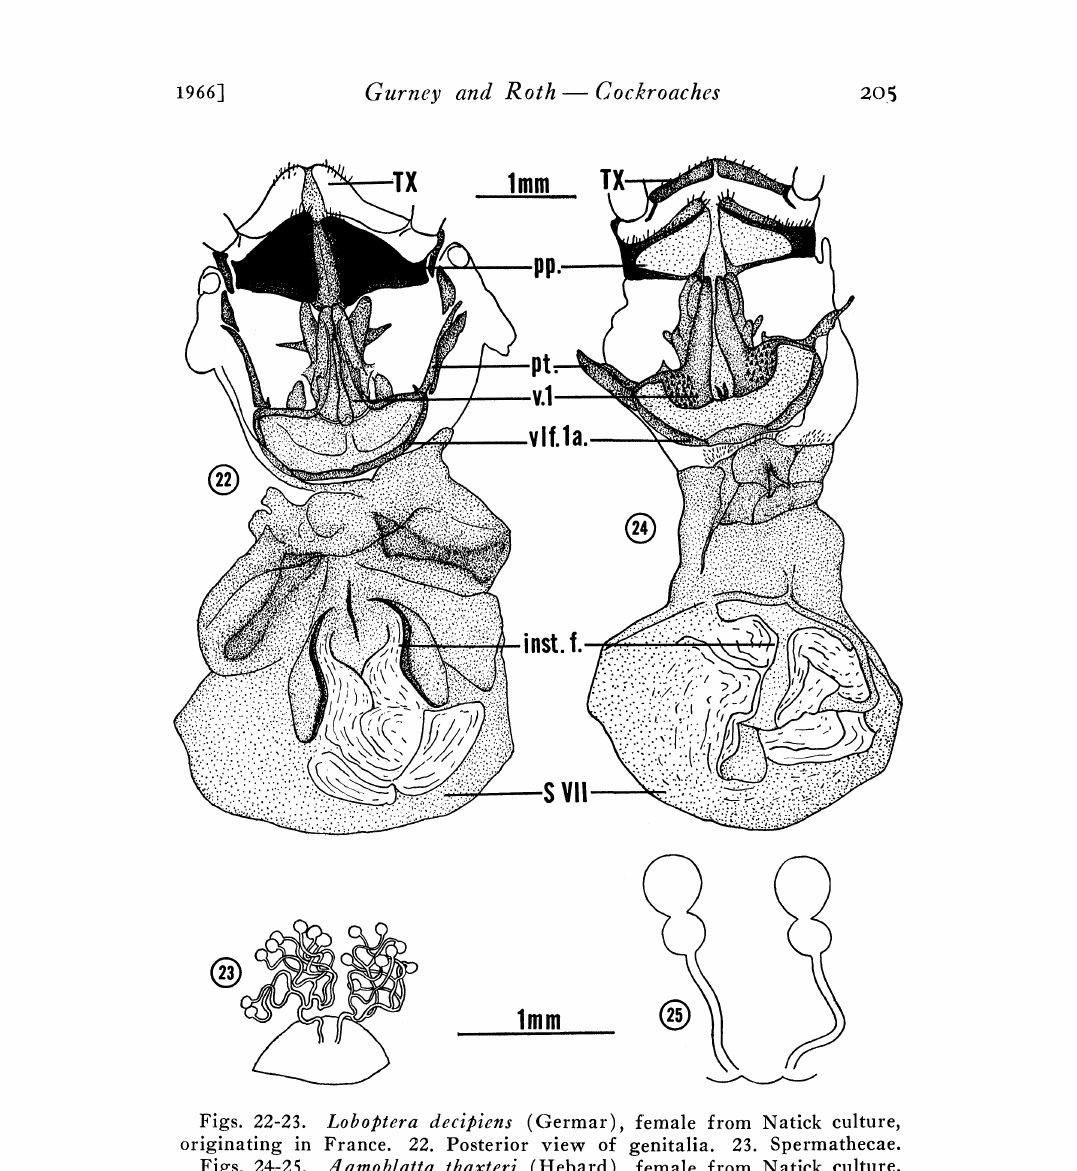
Figs. 22-23. Loboptera deciiens (Germar), female from Natick culture, originating in France. 22. Posterior view of genitalia. 23. Spermatheeae. Figs. 24-25. Zlgmoblatta thaxteri (Hebard), female from Natick culture, originating in Buenos Aires, Argentina. 24. Posterior view of genitalia. 25. Spermathecae. Abbreviations" inst.